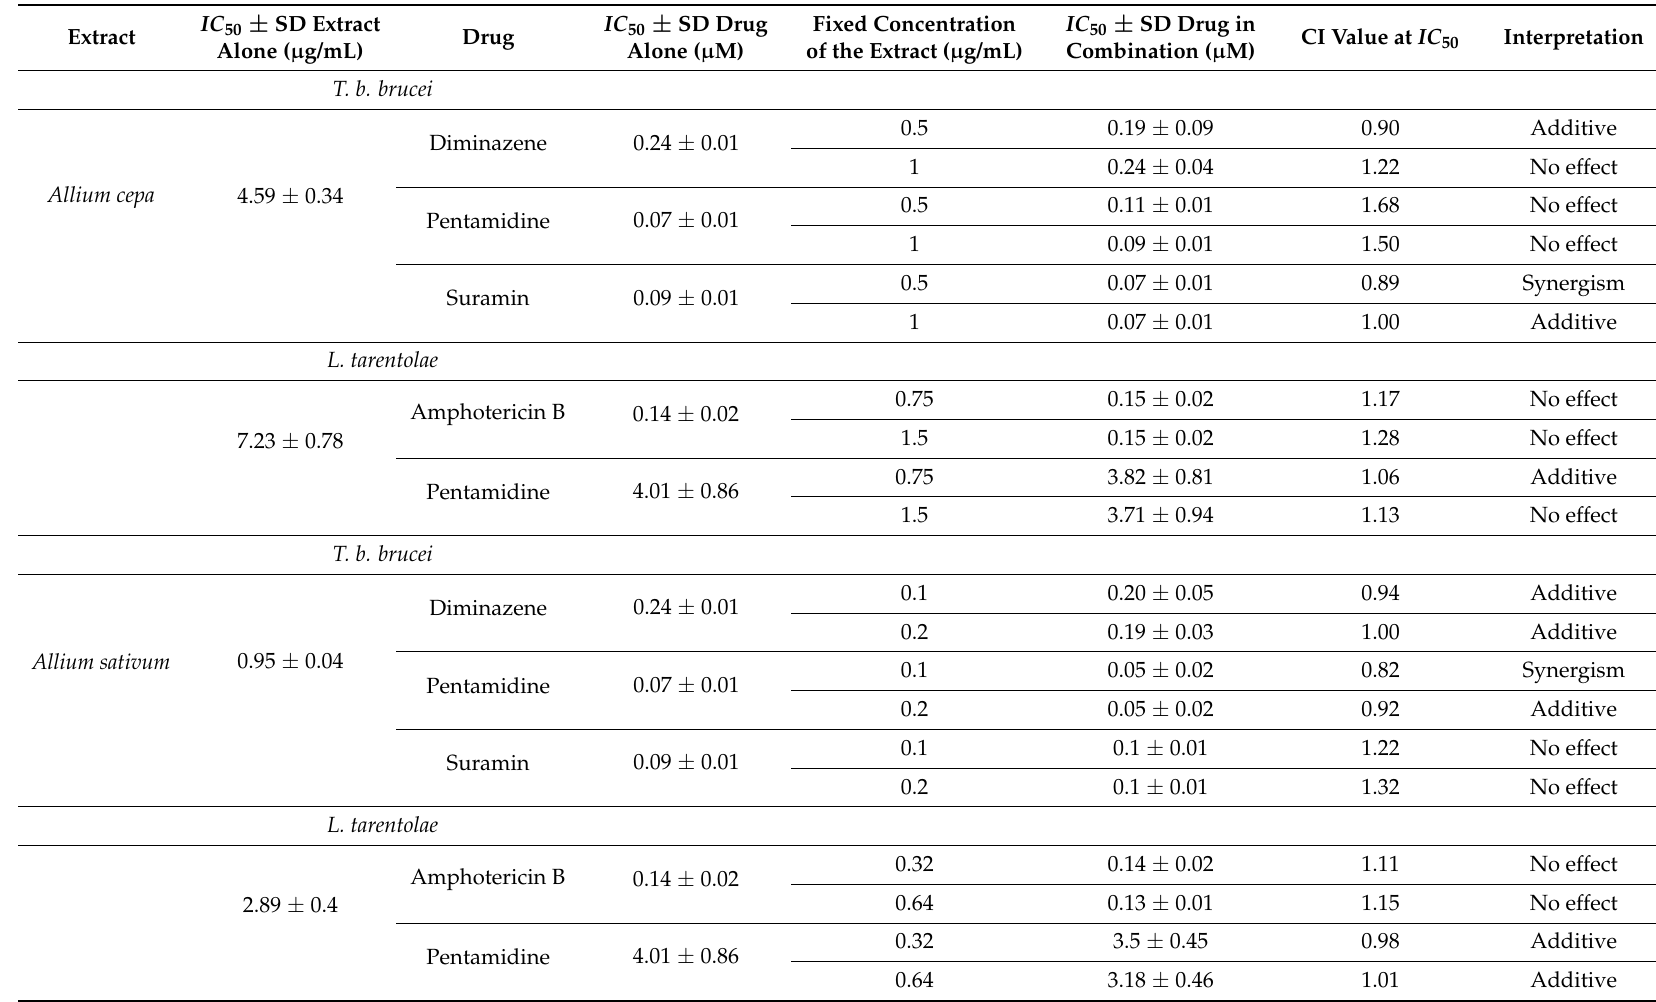
Table 5. Combinations of Allium sativum (garlic) and Allium cepa (onion) extracts with common trypanocidal (diminazene, pentamidine and suramin) and leishmanicidal (amphotericin B and pentamidine)